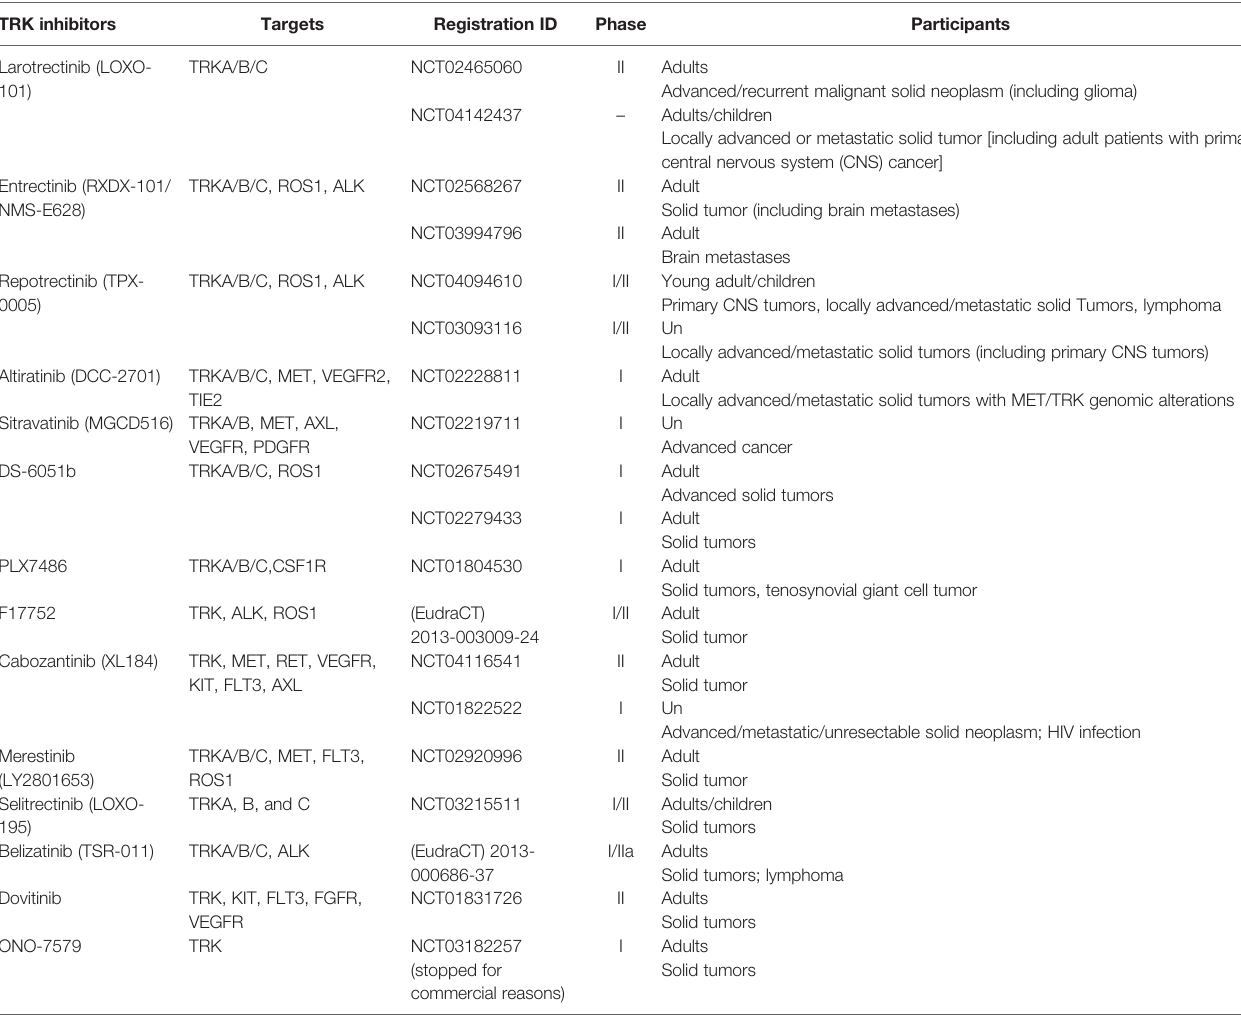
TABLE 3 | Ongoing clinical trials of TRK inhibitors as target therapy to NTRK